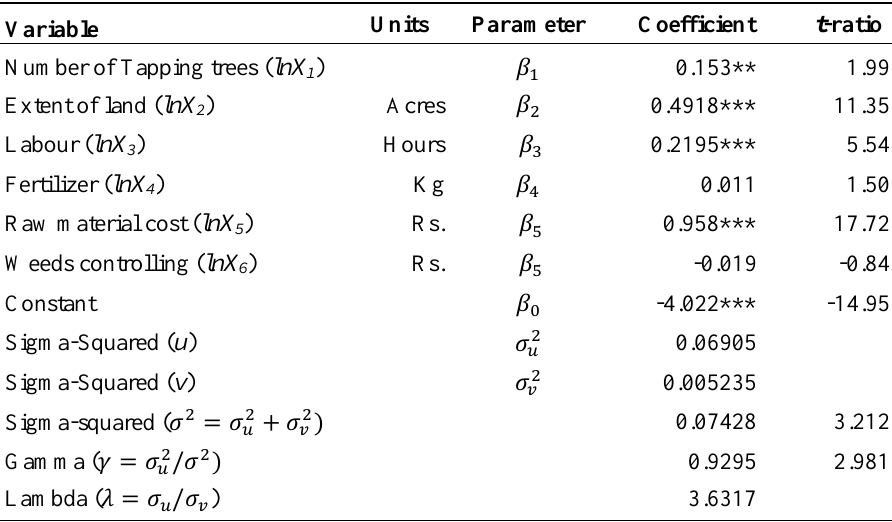
Table 4: Maximum Likelihood Estimates for Parameters of the Stochastic Frontier Production